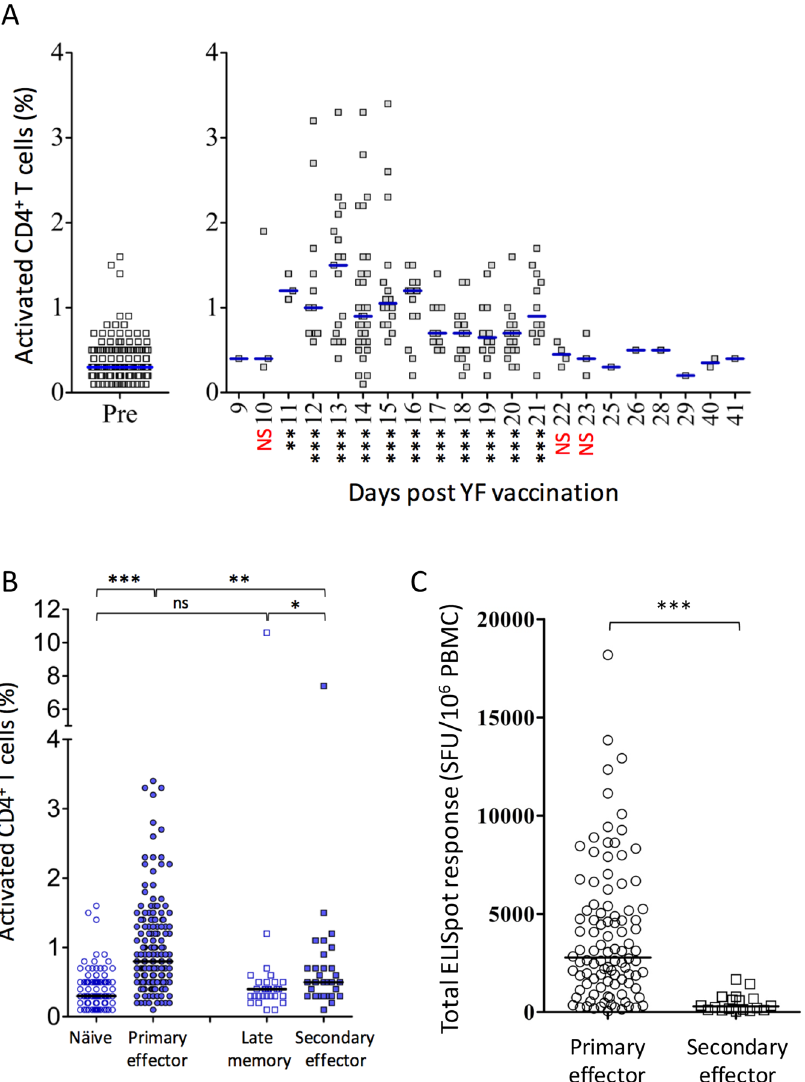
Figure 3. Activation of CD4 + T cells after primary and booster YF-17D vaccination. PBMCs were analysed by flow cytometry, and activated CD4 + T cells were defined as CD38 + HLA-DR + CD4 + CD3 + T cells (see supplementary Figure S2, right-hand panel). ( A) Frequencies of activated CD4 + T cells before and after YFV vaccination. Pre- (day 0) and post-vaccination (day 9 to 41) PBMCs from 209 primary YFV vaccinated donors were analysed. In the left-hand panel, pre-vaccination frequencies are plotted; in the right-hand panel, the post-vaccination frequencies are plotted according to the day the blood sample was collected. The median for each collection day is indicated. Mann Whitney U test was used to determine the significance of the difference between day 0 pre-vaccination, and the indicated day post vaccination ( *** p < 0.001; ** p = 0.004; if nothing is given the sample size is too small). ( B) The activation level of CD4 + T cells from primary and booster vaccinated donors before and after YFV vaccination. CD4 + T cell activation status was determined for PBMCs from primary vaccinated donors before (“naïve”; n = 147) and after (“primary effectors”; n = 178) vaccination and for PBMCs from booster vaccinated donors before (“late memory”; n = 29) and after (“secondary effectors”; n = 29) vaccination. The median is indicated. A Mann Whitney U test was used to determine the significance of the difference between the indicated groups ( *** p < 0.0001; ** p = 0.001; * p = 0.0264; ns: not significant). ( C) The total YFV specific CD4 + and CD8 + T cell responses in primary and booster vaccinated donors were analysed. PBMCs from primary vaccinated donors (“primary effector”; n = 100) and from booster-vaccinated donors (“secondary effector”; n = 18) were analysed ex vivo using IFN- γ specific ELISpot analysis using 30 peptide pools covering the entire YFV proteome. Only donors vaccinated 12–22 days prior to blood collection were included. For each donor, the total YFV specific T cell response was measured as the sum of IFN- γ specific cells (spot forming units, SFU per 10 6 PBMC). The median is indicated. Mann Whitney U test was used to determine the significance of the difference between the groups ( *** p <